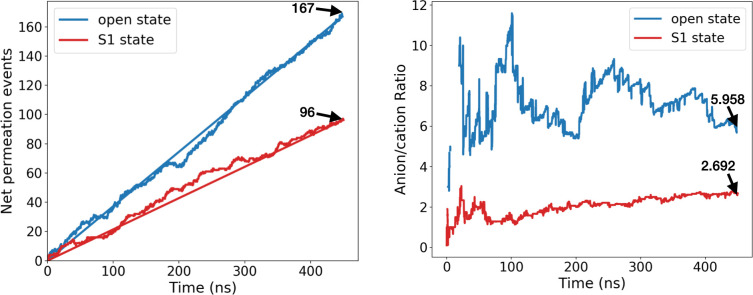
Net permeation events and anion/cation ratio in mVDCA1-Cys open state and subconducting S1 state.Values were obtained from 450-ns-long standard MD trajectories at +40mV. In the figure showing net permeation events, the line connecting the first and last points was plotted, the slope of which can be used to estimate the electric current (production MD (channel) in material and methods).